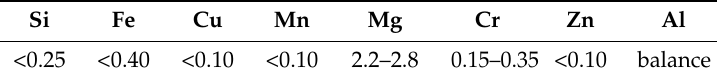
Table 2. Parameters of VPPA welding in digging process.